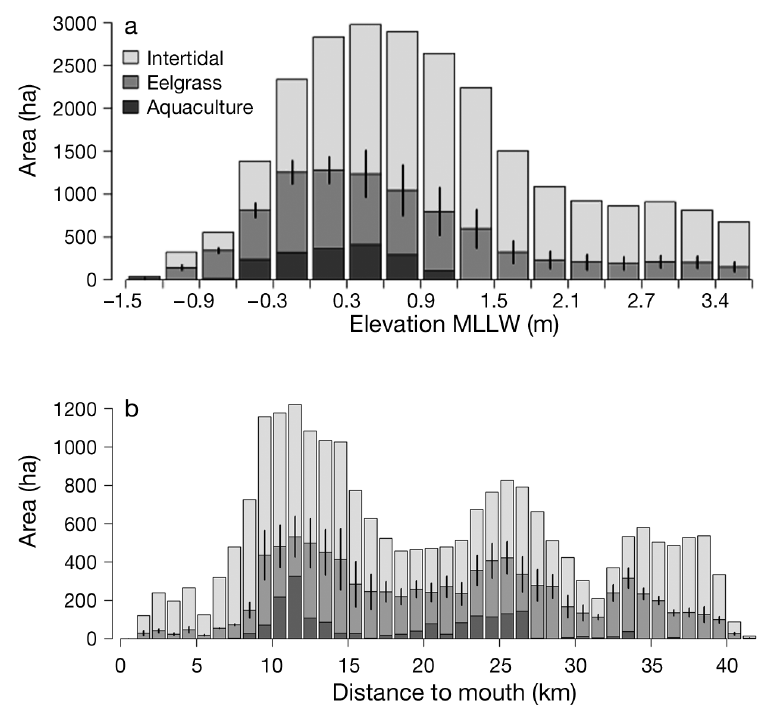
Fig. 2. (a) Frequency distribution of the area of intertidal zone, Zostera marina , and oyster aquaculture by tidal elevation and (b) distance to the estuary mouth in Willapa Bay. MLLW: mean lower low water (small bars for eelgrass represent SE)